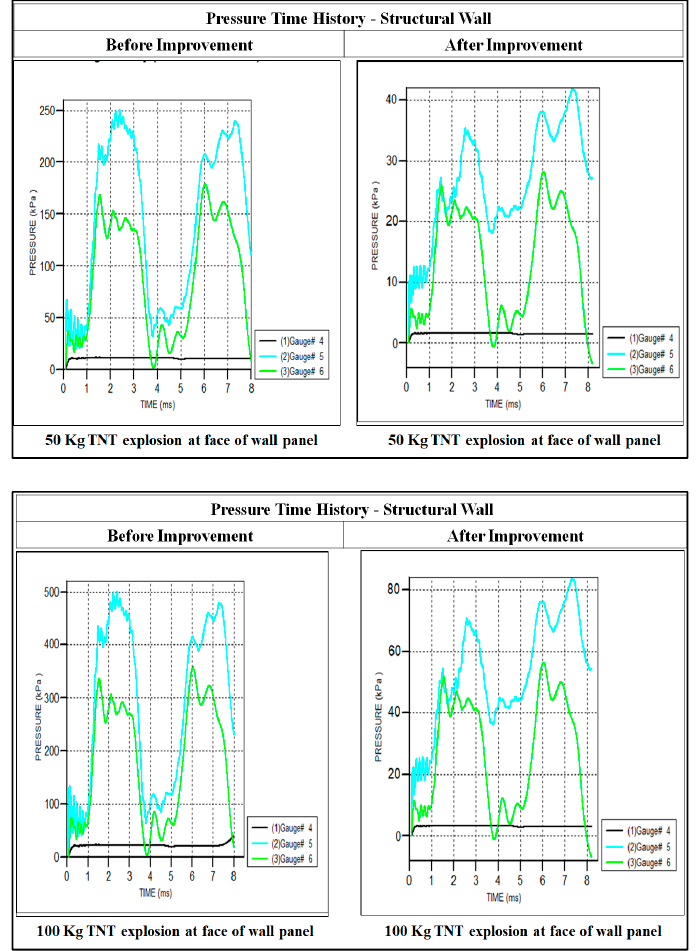
Figure 10. Comparison of TNT explosions at the face of RCC wall panels.